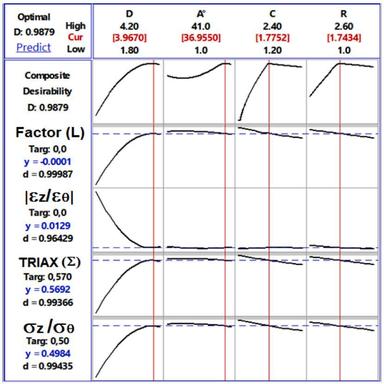
Results of the desirability function in an optimization plot.